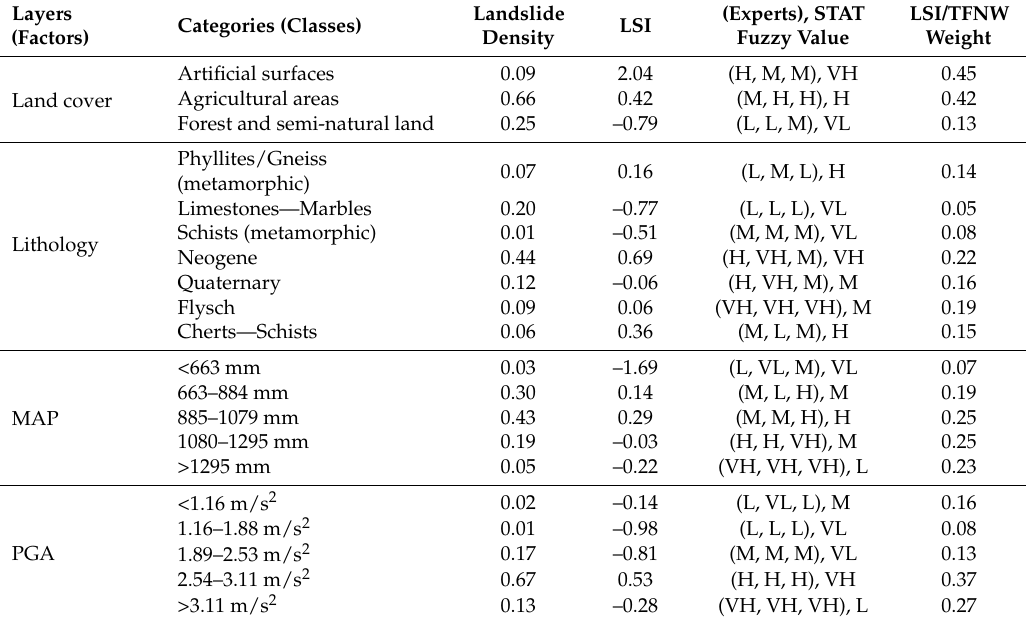
Table 1. Categories, landslide densities, susceptibilities (LSI), fuzzy values and weights for landslide related